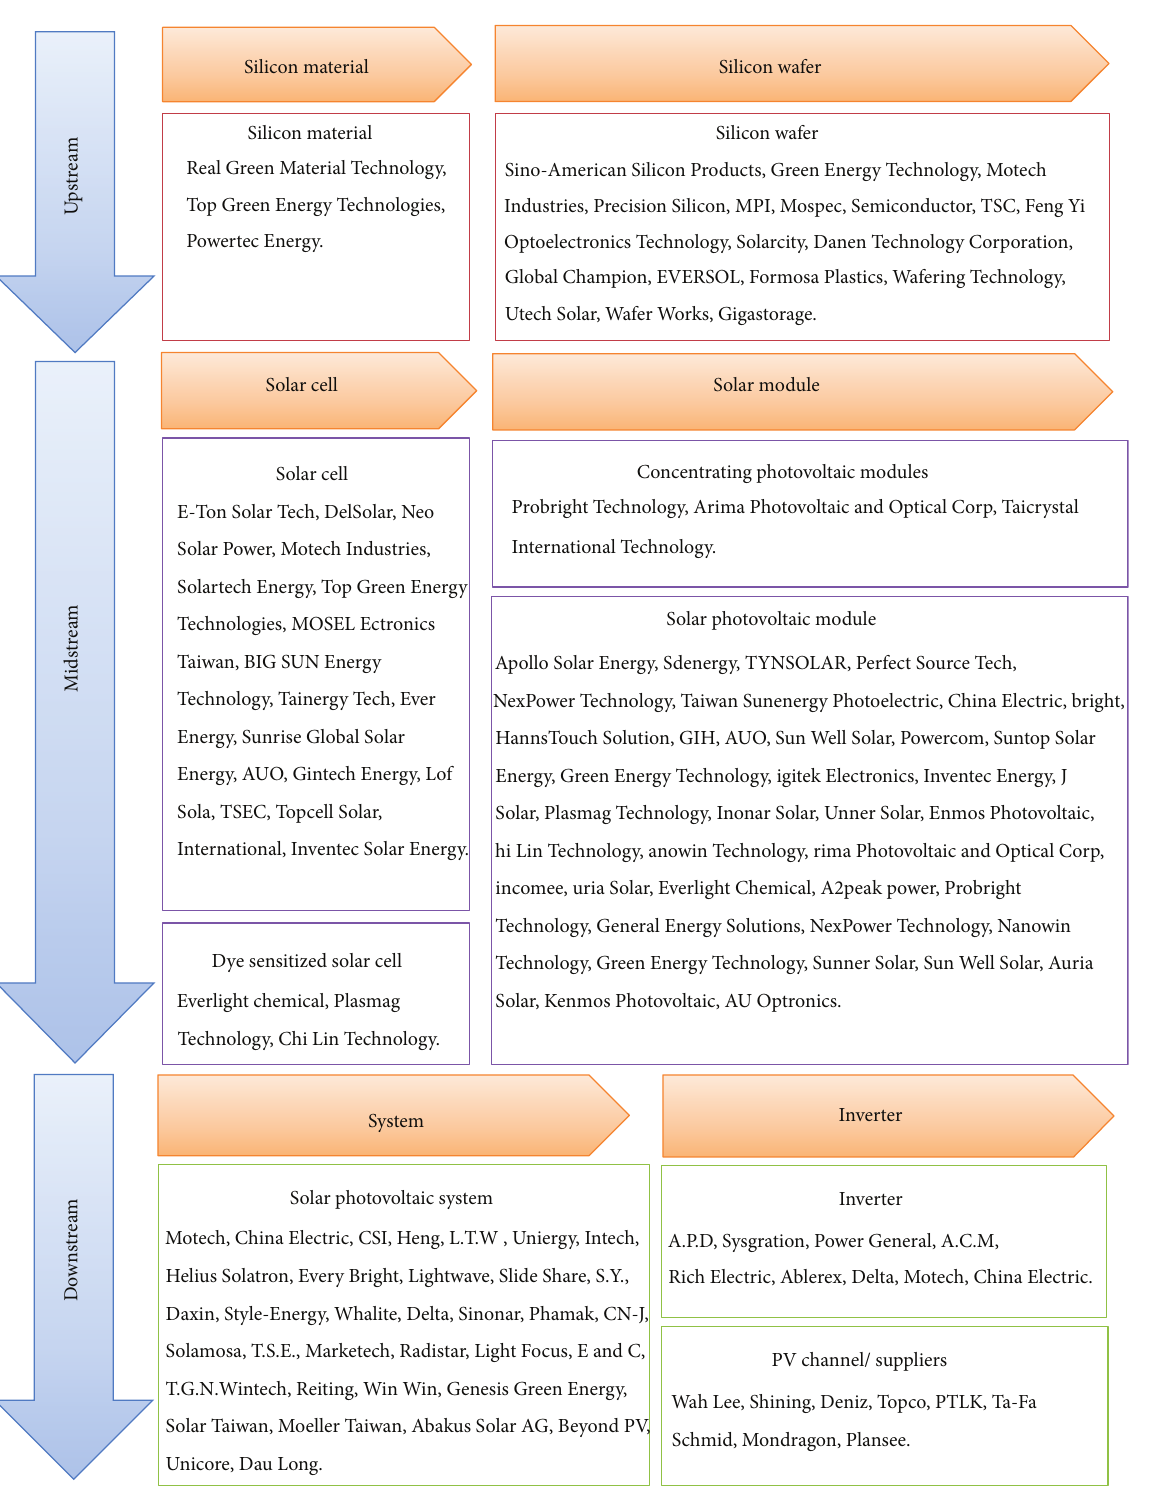
Figure 10: Value chain of the Taiwanese solar photovoltaic industry. Source: Green Energy Industry Information Net (2012)